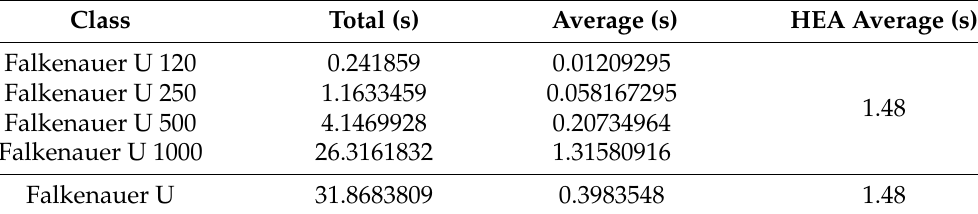
Table 7. Running times of the Falkenauer U benchmark problems, compared to HEA average.